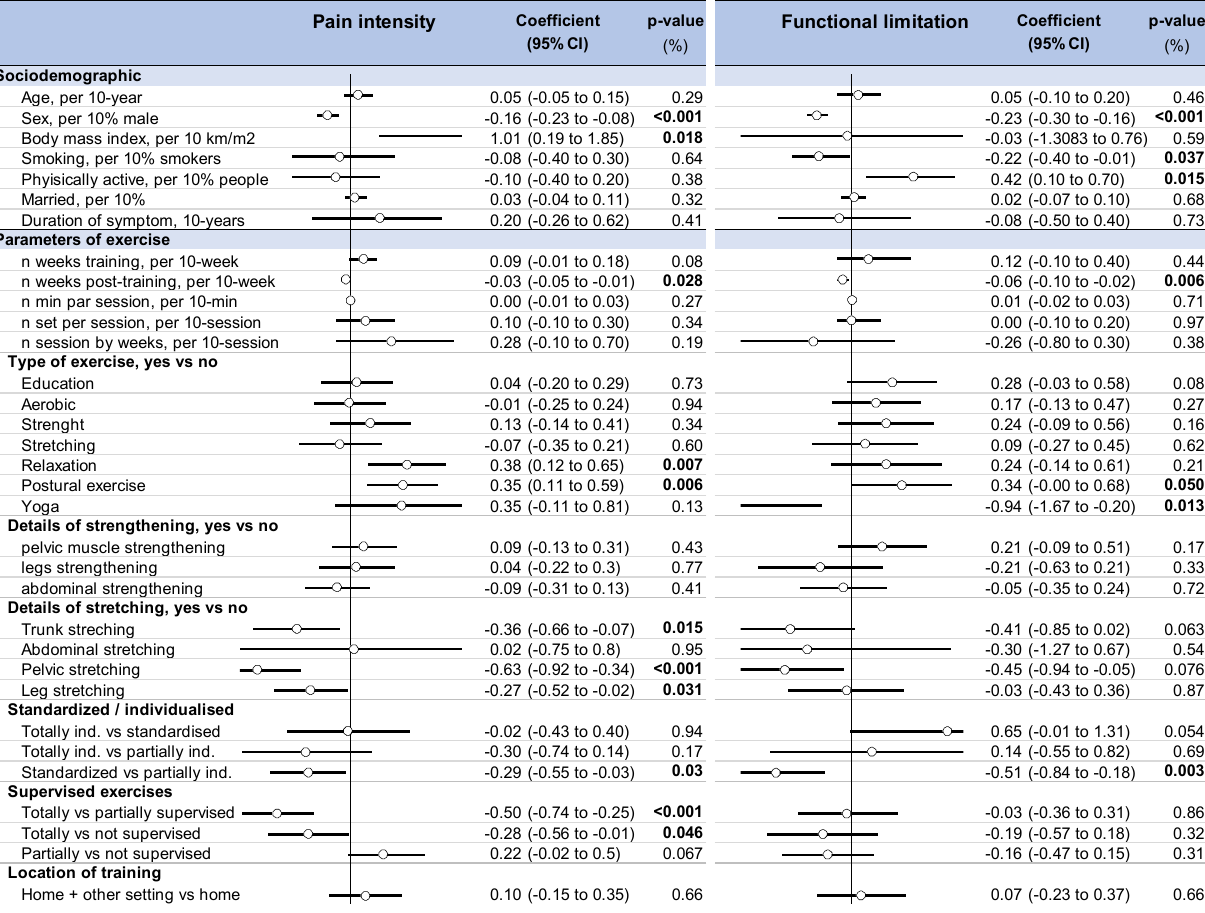
Figure 5. Metaregressions i.e., putative influencing variables on pain intensity and functional limitation following home- based exercise in LBP.